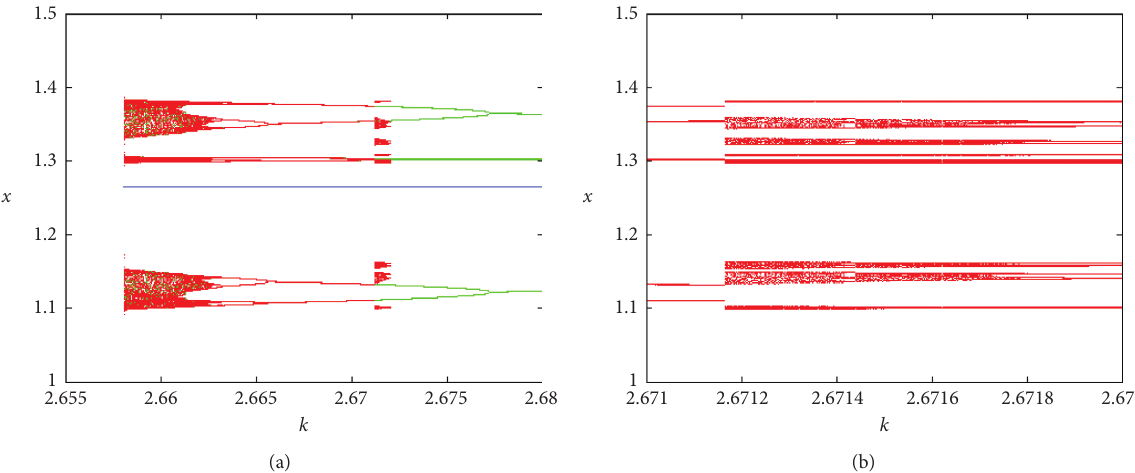
Figure 9: Enlargement of the bifurcation diagram of Figure 7(a), in the intervals 2.6575 ≤ k ≤ 2.68 (a) and 2.671 ≤ k ≤ 2.672 (b), revealing the coexistence of attractors in the form of parallel